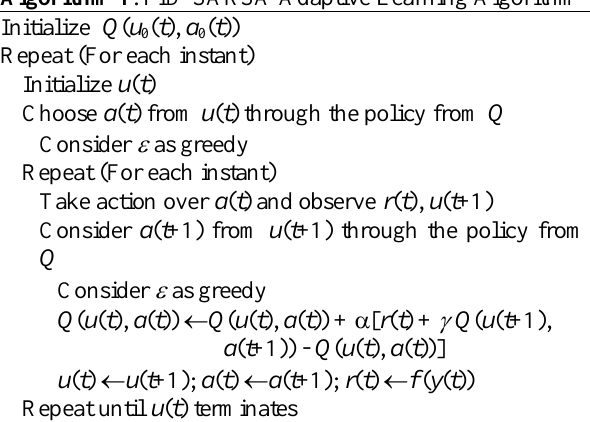
Algorithm 1 : PID-SARSA Adaptive Learning Algorithm